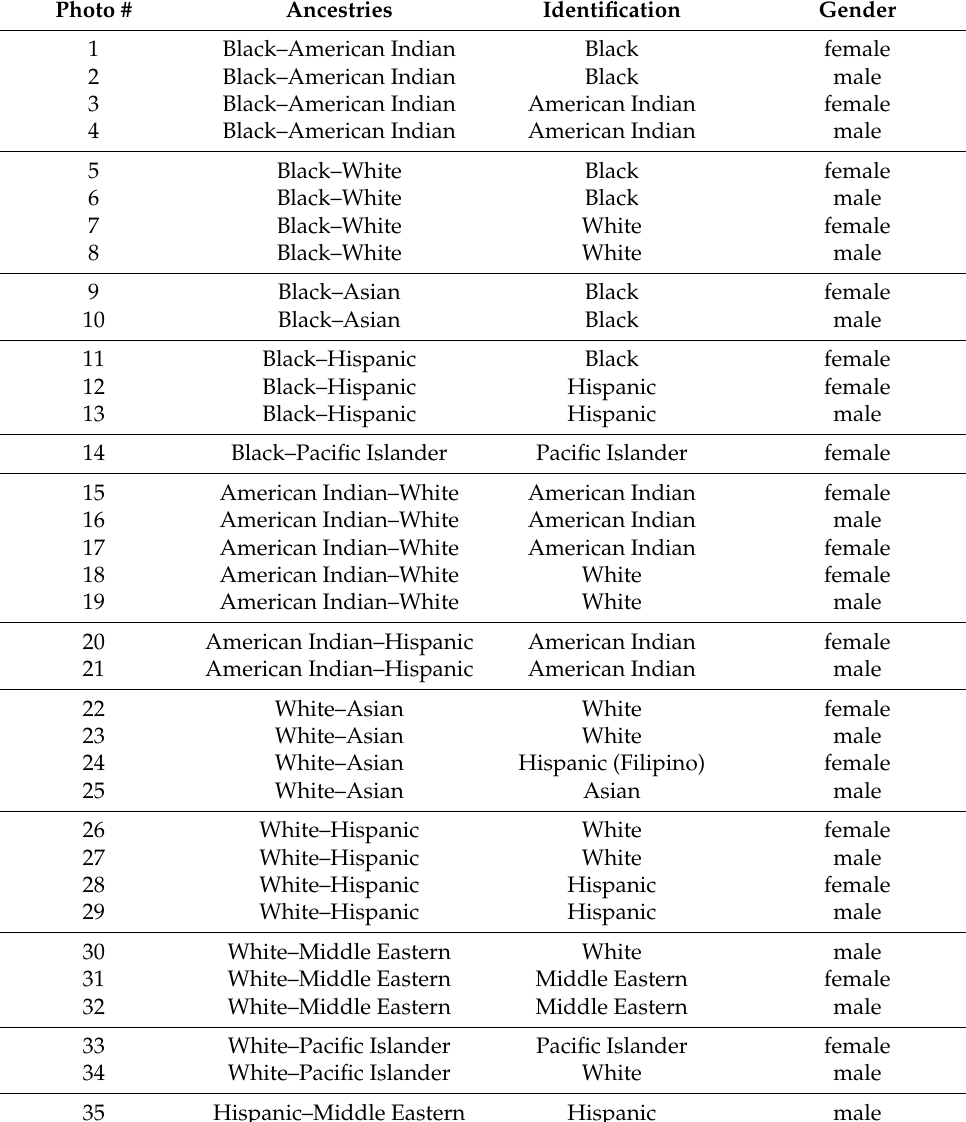
Table 1. Target ancestry, identification, and